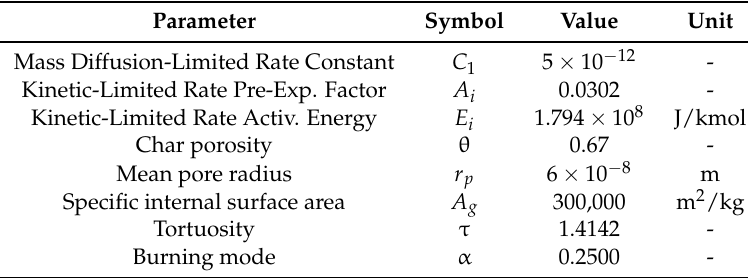
Table 7. Parameters for the char burnout intrinsic model.